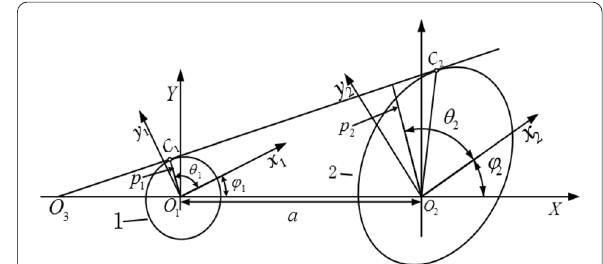
Figure 4 Transmission relationships between driving and driven